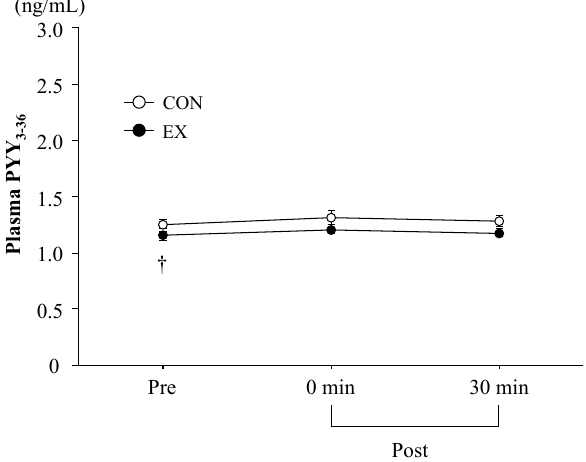
Figure 2. Change in plasma PYY 3 ‐ 36 concentrations. Values are means ± SE. † p < 0.05 vs. CON.